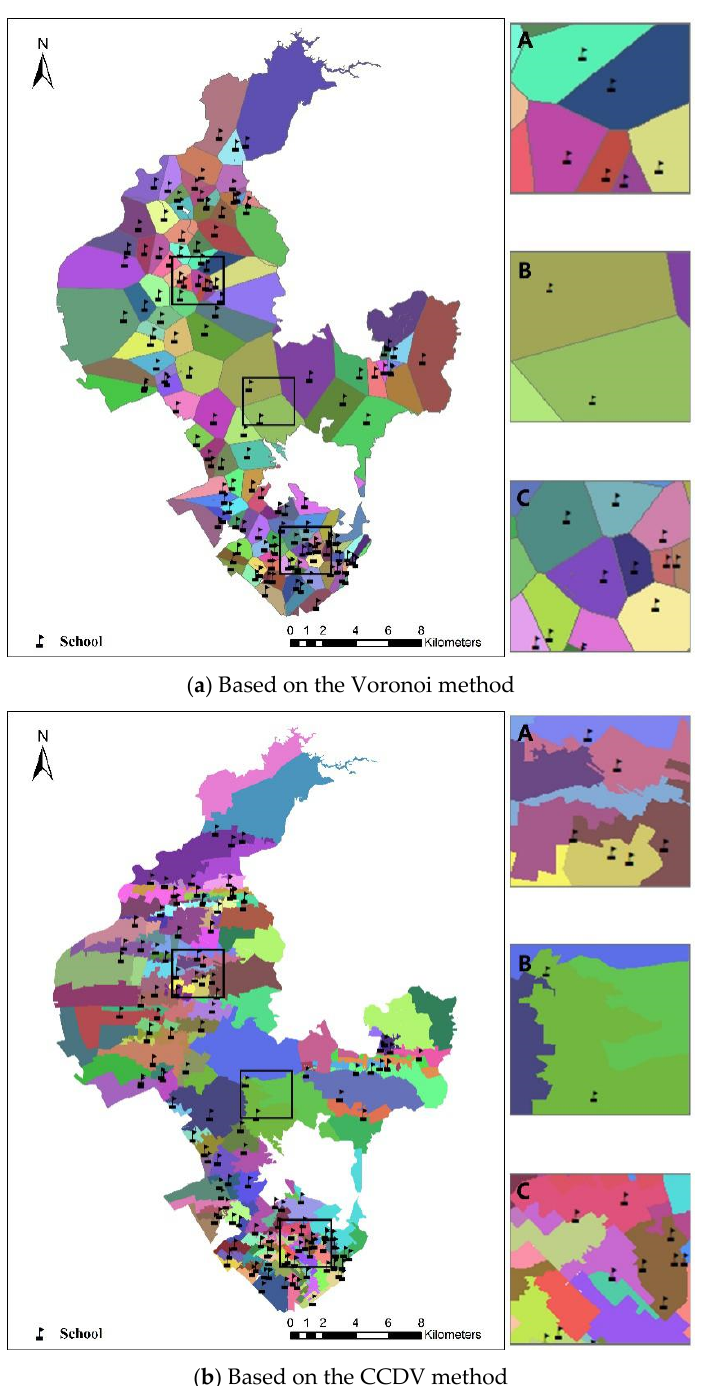
Figure 4. School district division results.